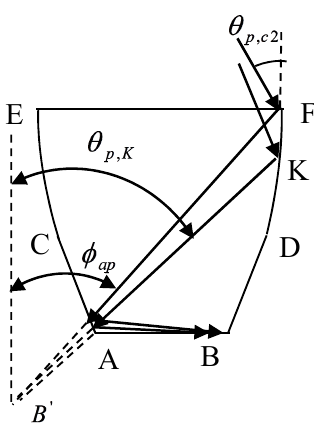
θ > θ . p a θ > θ . p a